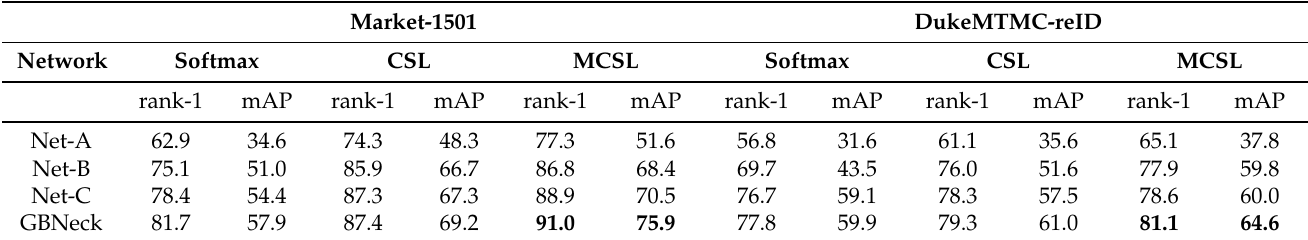
Table 1. Rank-1 and mAP of the four network frameworks. Bold fonts denote the highest values.